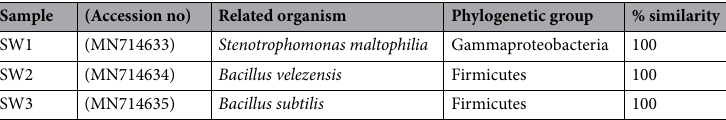
Table 1. 16S rRNA gene sequences based on BLAST